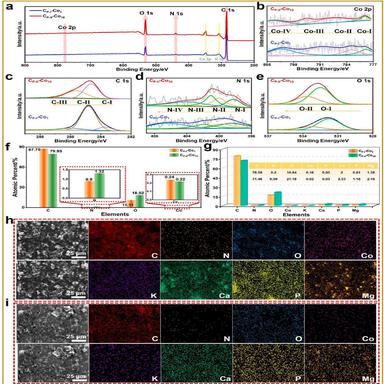
XPS spectra of CP-I-Co1 and CP-II-Co10: a) full spectra, and the respective high-resolution XPS spectra of b) Co 2p, c) C 1s, d) N 1s, and e) O 1s; f) the atomic percentage of C, N, O, and Co for CP-I-Co1 and CP-II-Co10 in XPS analysis; g) the atomic percentage of C, N, O, Co, K, Ca, P, and Mg for CP-I-Co1 and CP-II-Co10 in energy spectrum analysis; h) energy spectrum analysis of C, N, O, Co, K, Ca, P, and Mg elements in CP-I-Co1; and i) energy spectrum analysis of C, N, O, Co, K, Ca, P, and Mg elements in